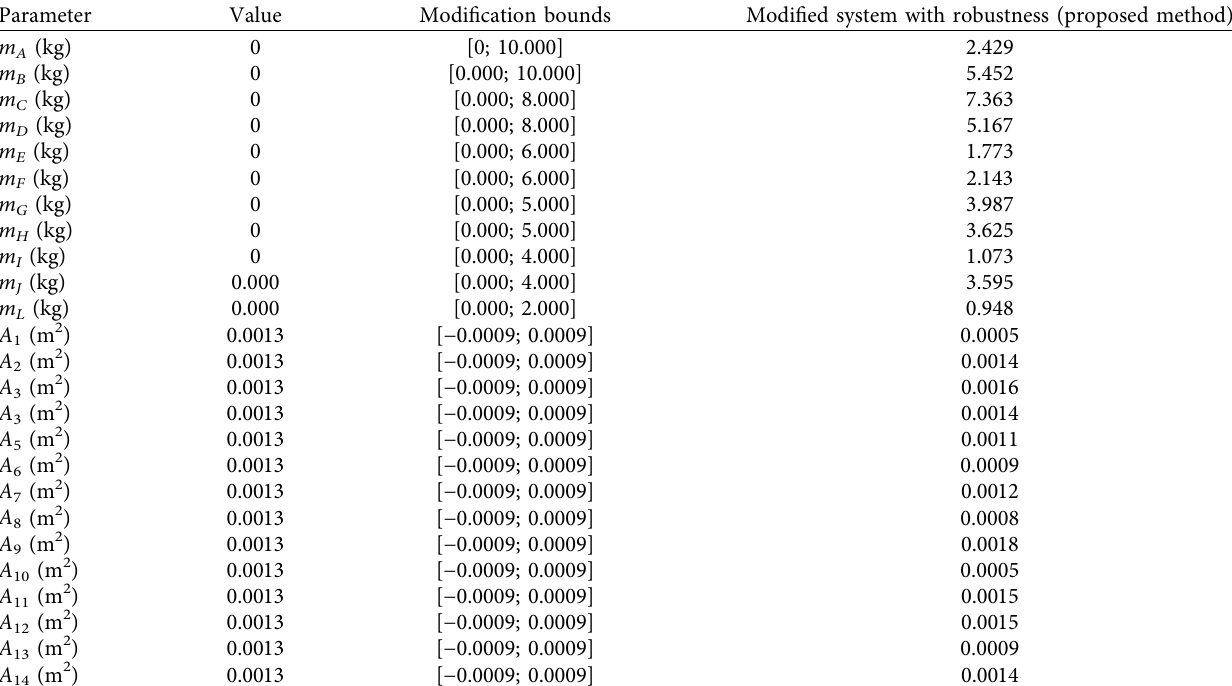
Figure 10: Test-case 4: sketch of the cantilever truss structure. Table 14: Test-case 4: original and modified system design variables and constraints.